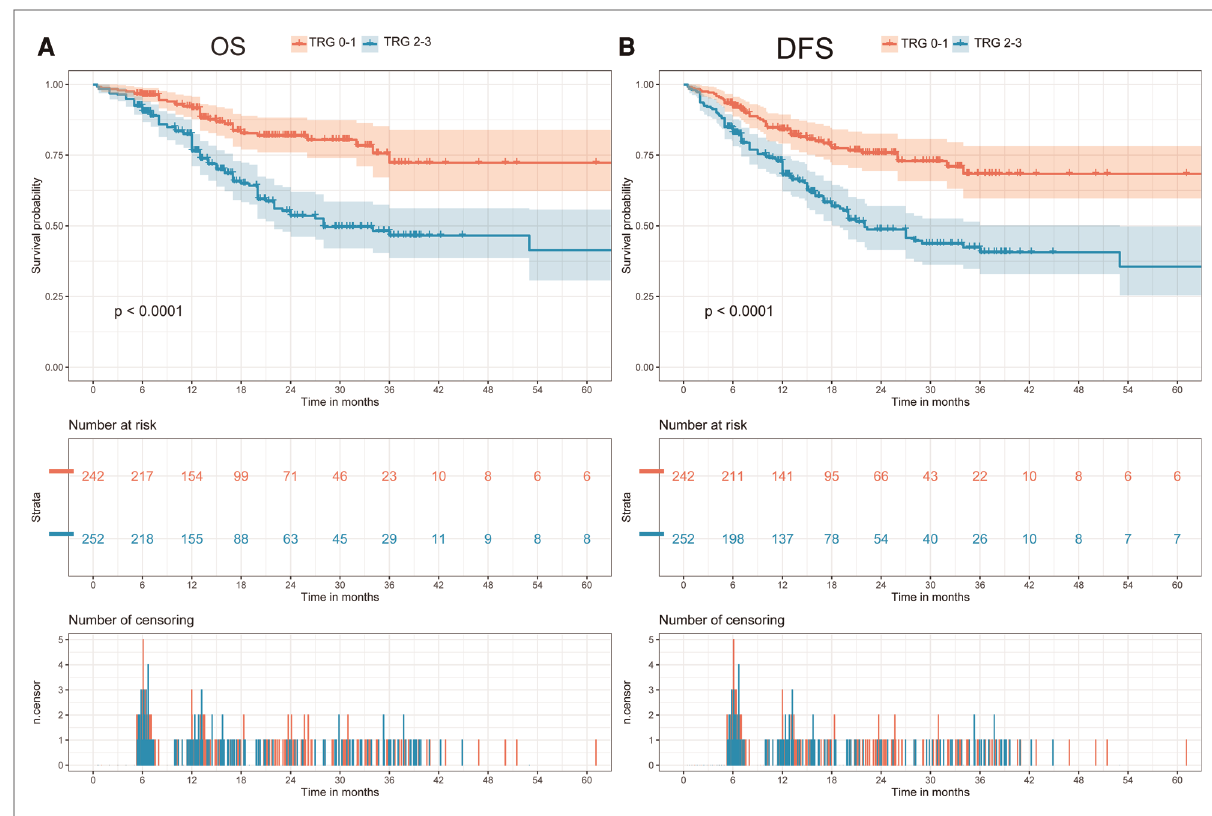
FIGURE 3 Comparison of overall survival (OS) and disease-free survival (DFS) between two groups (TRG 0-1 vs. TRG 2-3). ( A ) Comparison of OS between two groups (TRG 0-1 vs. TRG 2-3). ( B ) Comparison of DFS between two groups (TRG 0-1 vs. TRG